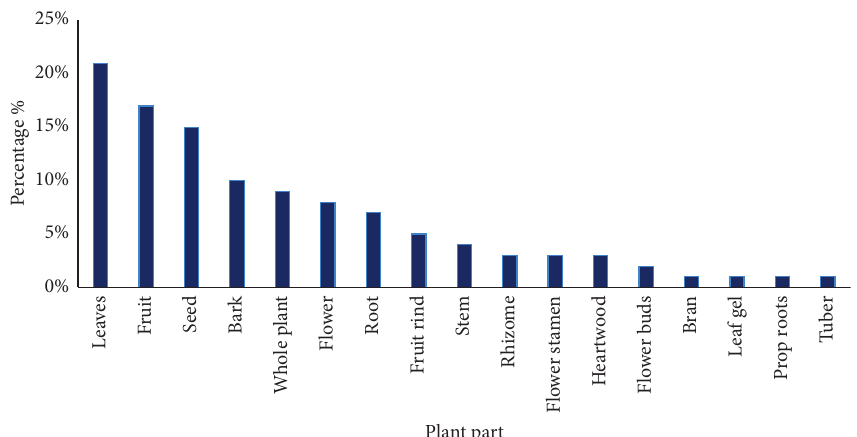
Figure 3: Different parts of the plants used in herbal cosmetics manufacturing of Sri